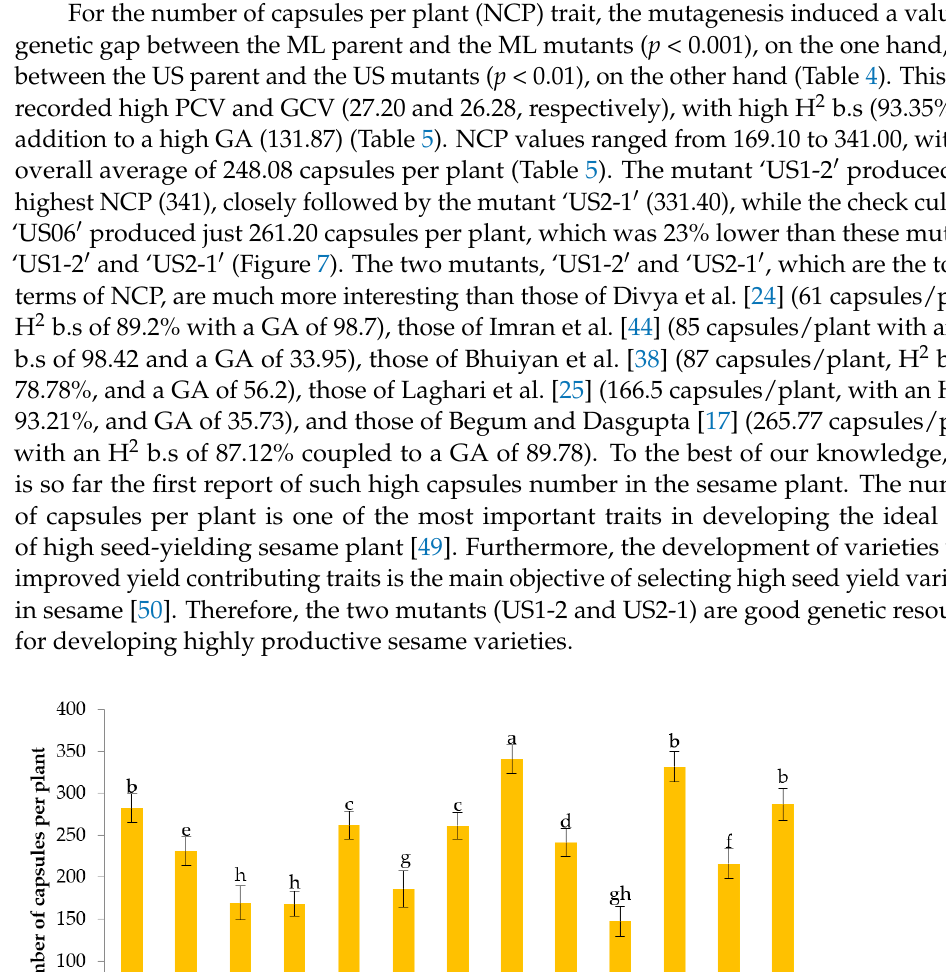
Figure 8. Number of seeds per capsules (NSC) in 11 sesame mutant lines and their two wildtypes (US06 and ML13). The superscript letters represent the groups according to Duncan’s test.